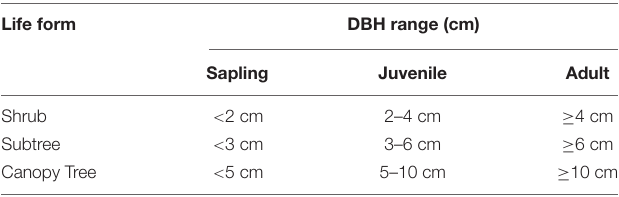
Life form DBH range